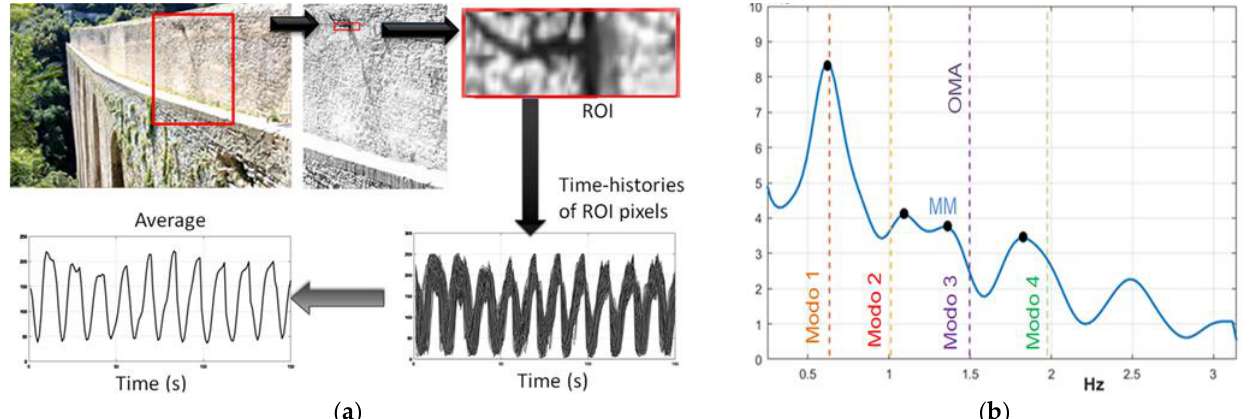
Figure 10. Analysis of the MM data from the Ponte delle Torri: ( a ) selected region-of-interest (ROI) and related processing flow; ( b ) typical PSD of an MM run with the first four peaks (bold black dots) compared to the modal frequencies identified through OMA of seismograph data (colored dashed vertical lines).